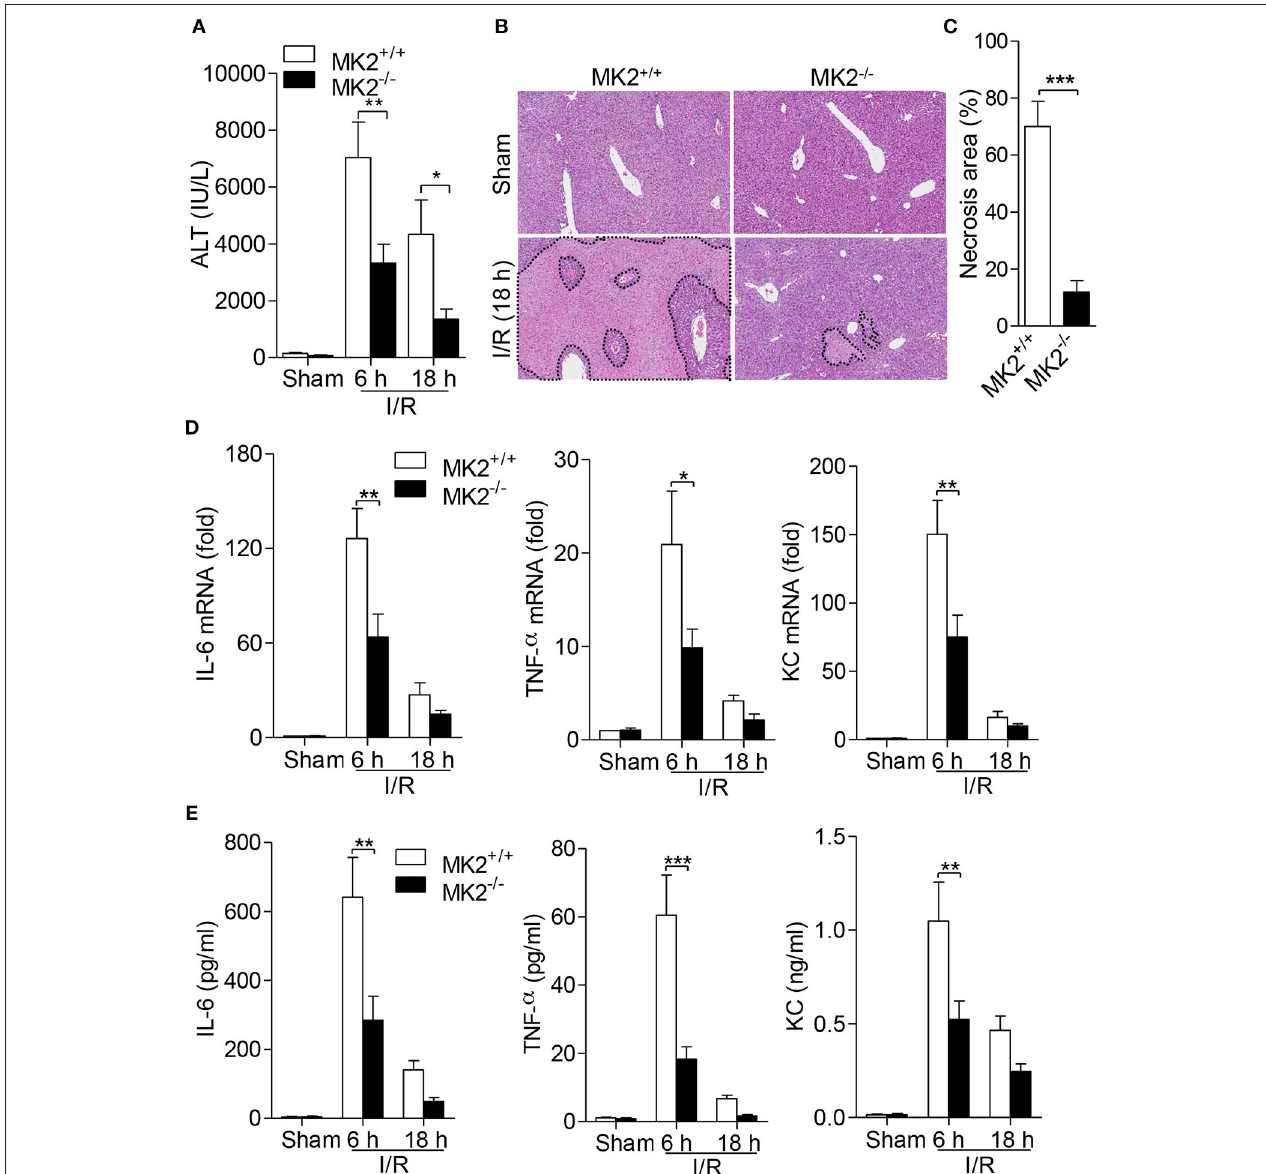
FIGURE 1 | Genetic MK2 deficiency alleviated hepatic I/R injury and inflammatory cytokine production. MK2 + / + and MK2 − / − mice were subjected to 60min of partial liver warm ischemia, followed by reperfusion for 6 and 18h. (A) Mouse blood was collected and serum ALT was detected. (B) Hepatic I/R injury was evaluated by hematoxylin-and-eosin (H&E) staining of injury liver tissues. Original magnification × 100. (C) The necrosis area was quantified by using ImageJ software. (D) The mRNA levels of IL-6, TNF- α , and KC in injury livers were detected by qPCR. (E) The protein levels of IL-6, TNF- α , and KC in serum were detected by ELISA. The results are shown as means ± SEM. * P < 0.05; ** P < 0.01, *** P < 0.001, based on 5 mice in each